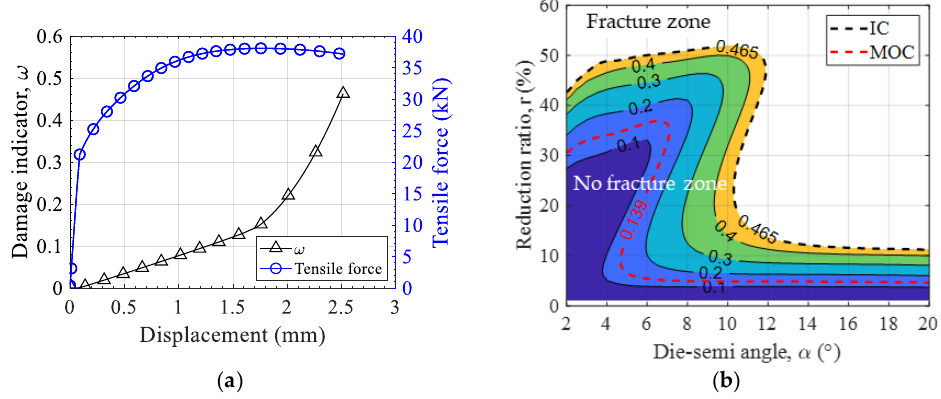
Figure 6. ( a ) Tensile force-displacement response and damage indicator w changes in the center element of the tensile specimen. ( b ) Process condition diagram (PCD) of SUJ2Z steel. Safe (no fracture) and unsafe (fracture) zones are distinguished by an IC. MOC represents a line connecting the set of points where the w crossed 𝑤 𝑈𝑇𝑆 .